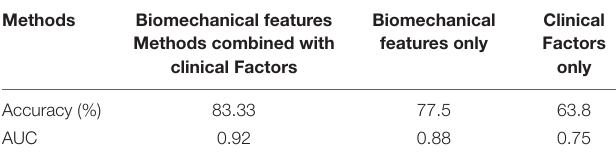
TABLE 4 | Performance comparison with different